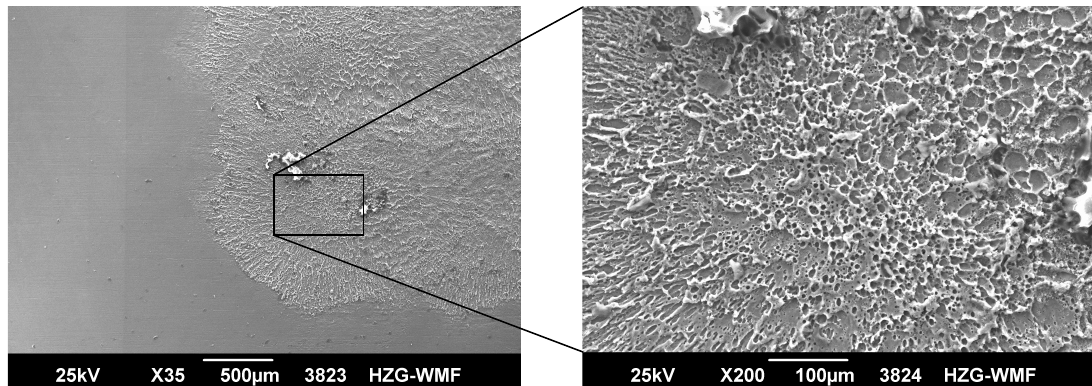
Figure 10. SEM micrographs of an AA2024-T3clad peened area applying two sequences by using a laser focus size of 1 mm × 1 mm and a laser pulse energy of 1.5 J. For the first sequence, the advancing direction was chosen to be orthogonal and, in the second sequence, parallel to the rolling direction (see Figure 1l). The surface area indicates molten surface material for the peened